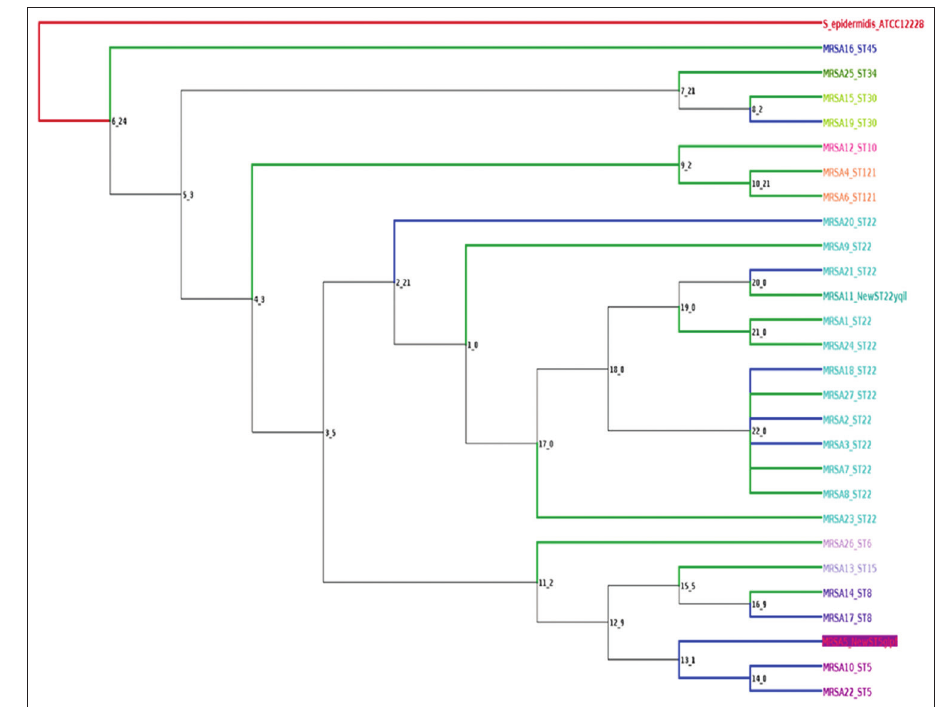
Figure-1: Dendrogram resulting from single-nucleotide polymorphisms analysis of Staphylococcus aureus